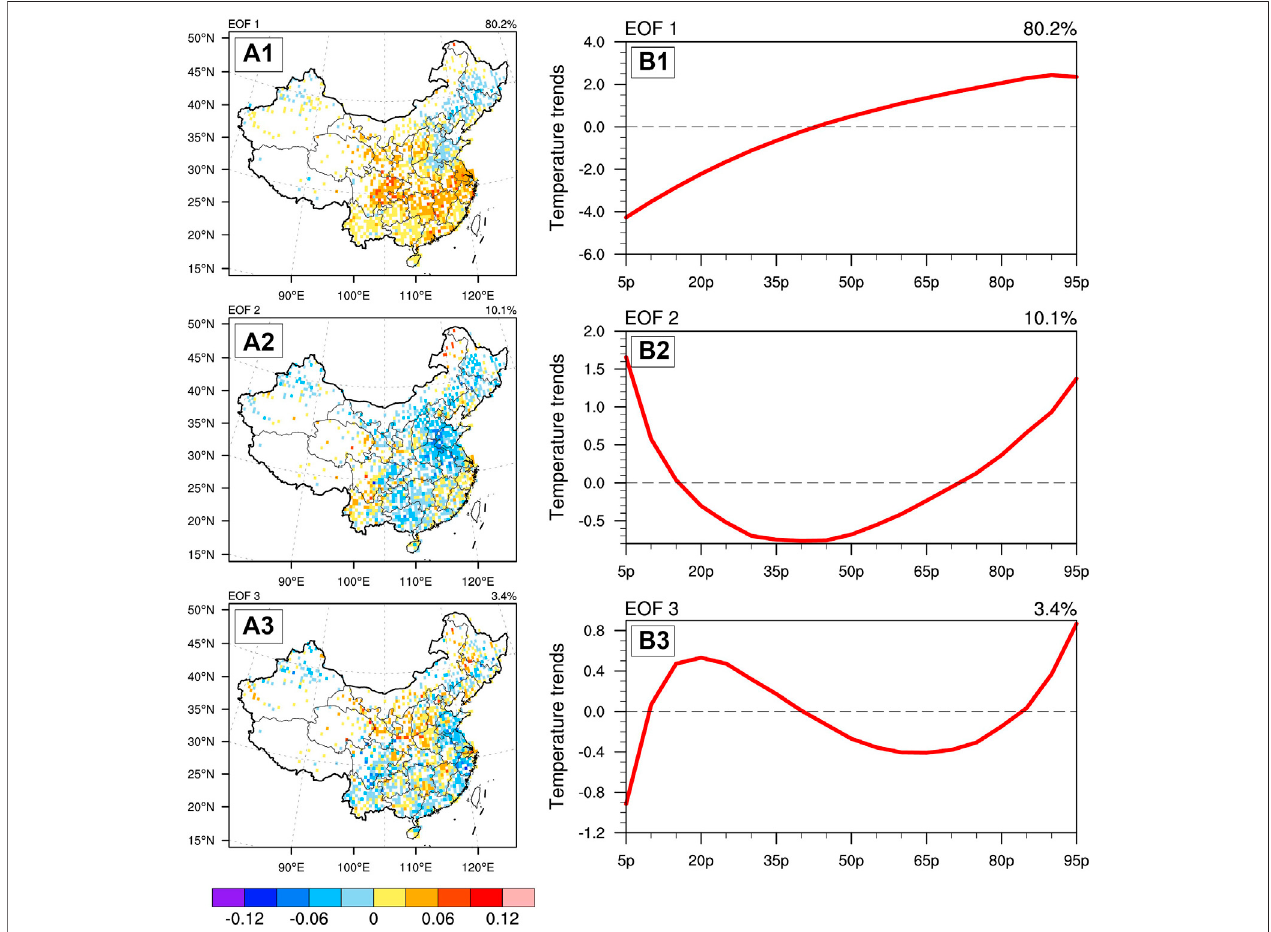
FIGURE 5 | The fi rst three empirical orthogonal function leading modes (A1 – A3) of the intra-quantile variations of Tmax in China, and the corresponding principal component (B1 – B3) . Note that the percent variance of each mode can be found in the upper right of each plot.